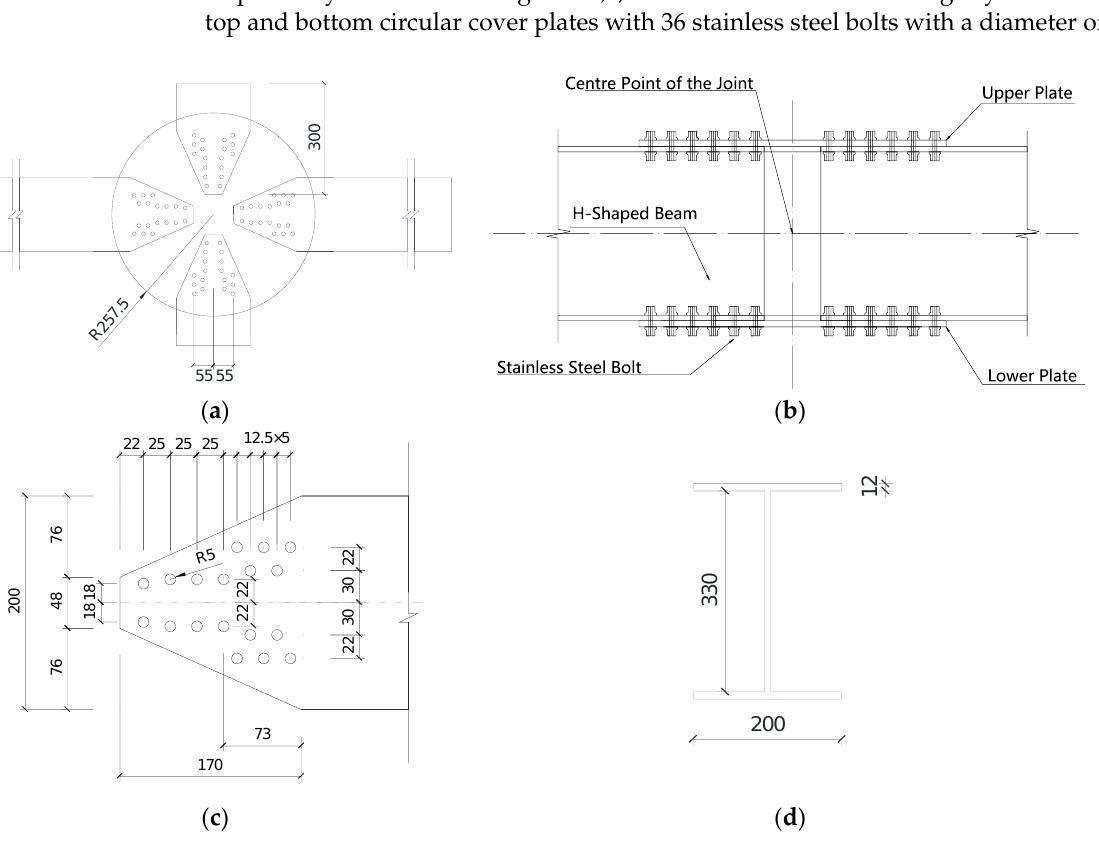
Figure 2. Dimensions of the AAG joint. ( a ) Diagram of plane view of the AAG joint; ( b ) diagram of lateral view of the AAG joint; ( c ) diagram of details of member in joint domain; ( d ) diagram of member section.